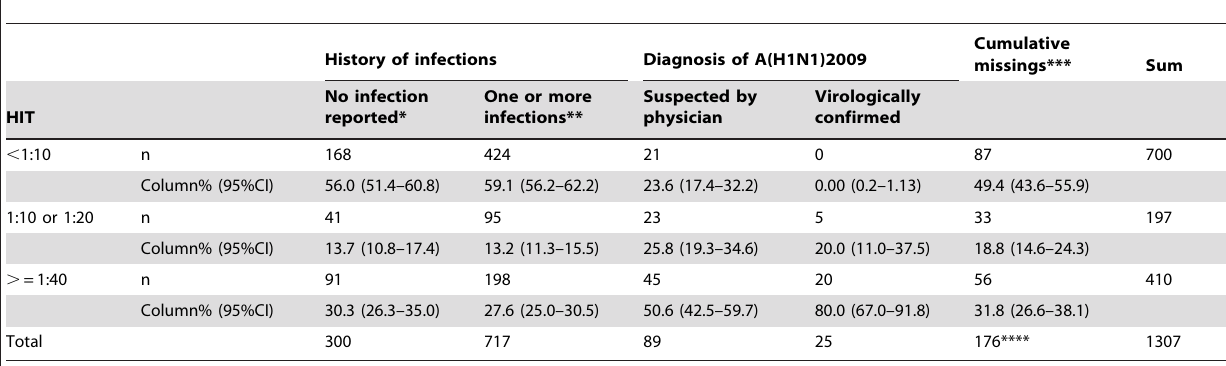
Table 3. History of infections and hemagglutination inhibition titers (HIT) in non-vaccinated children.